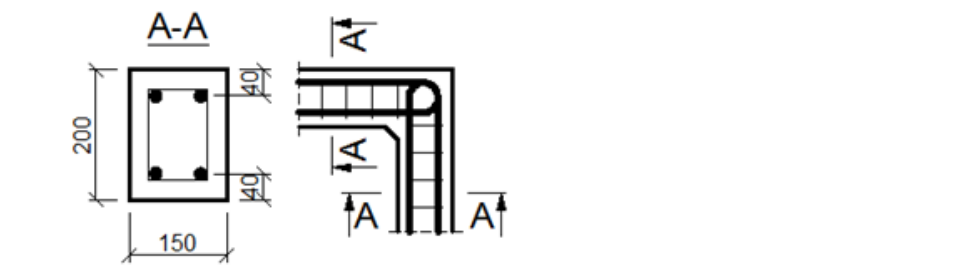
Figure 12. Geometry and main reinforcement for the case of elements with the same cross section heights; dimensions in (mm).